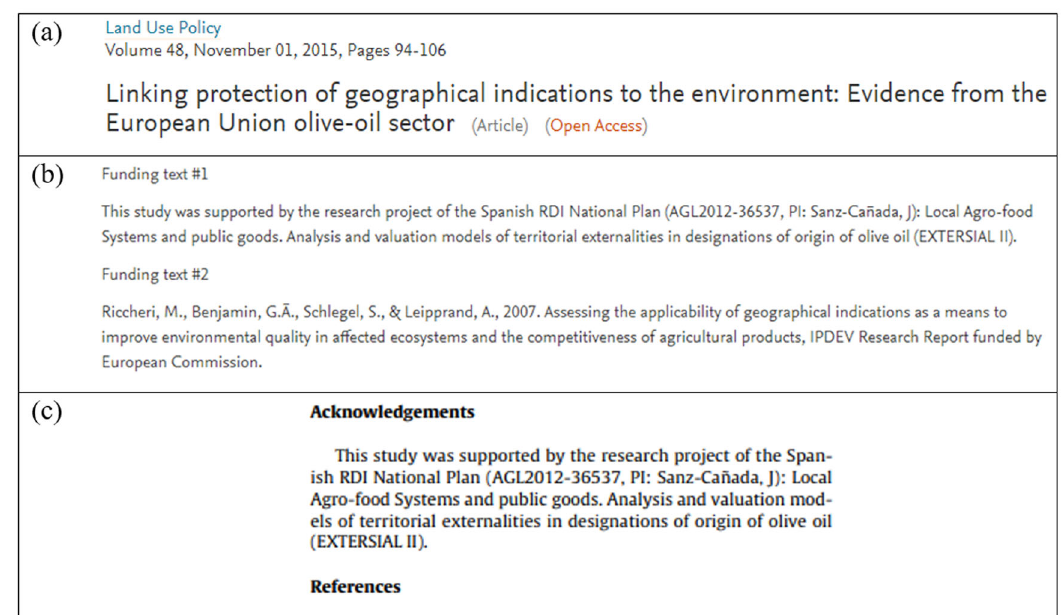
Fig. 1 Example of bibliographic reference in Scopus with funding text published in the references. a Bibliographic reference in Scopus. b Funding fi eld in the Scopus record including the funding text published in the article and a bibliographic reference, included in the reference list of the article, possibly listed automatically because of the inclusion of the term “ funded ” . c Acknowledgement published in the original